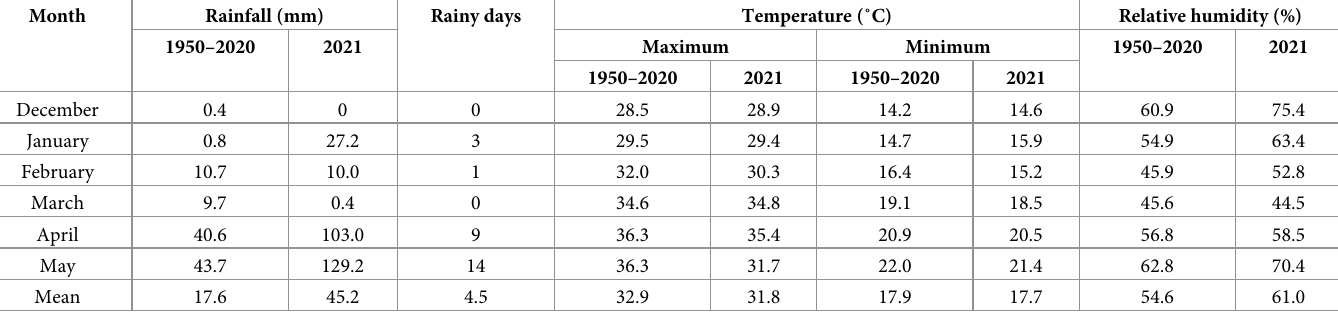
Table 2. Weather conditions during the crop period (December 2020 to May 2021) at Main Agriculture Research Station, UAS, Dharwad, Karnataka, India. Month Rainfall